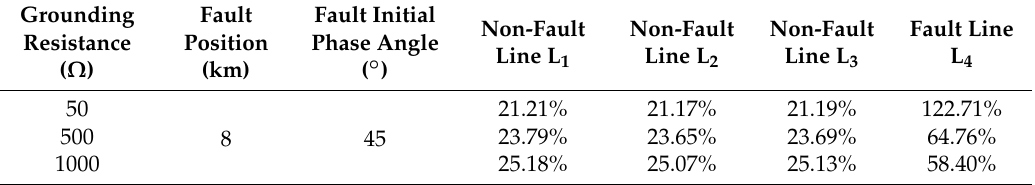
Table 4. The percentage of the DC component in SPG faults under different grounding resistances.